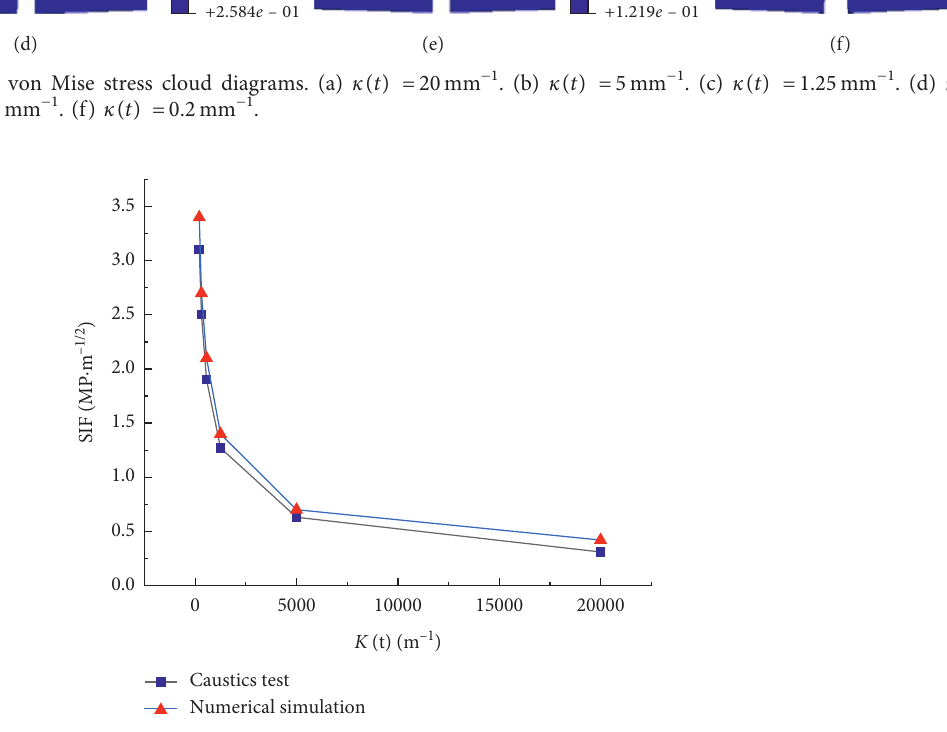
Figure 12: Comparison of the caustics test and numerical calculations.